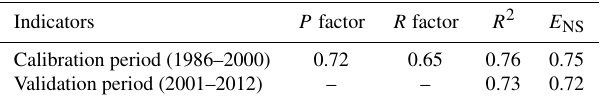
Table 2. Model performance in monthly streamflow in